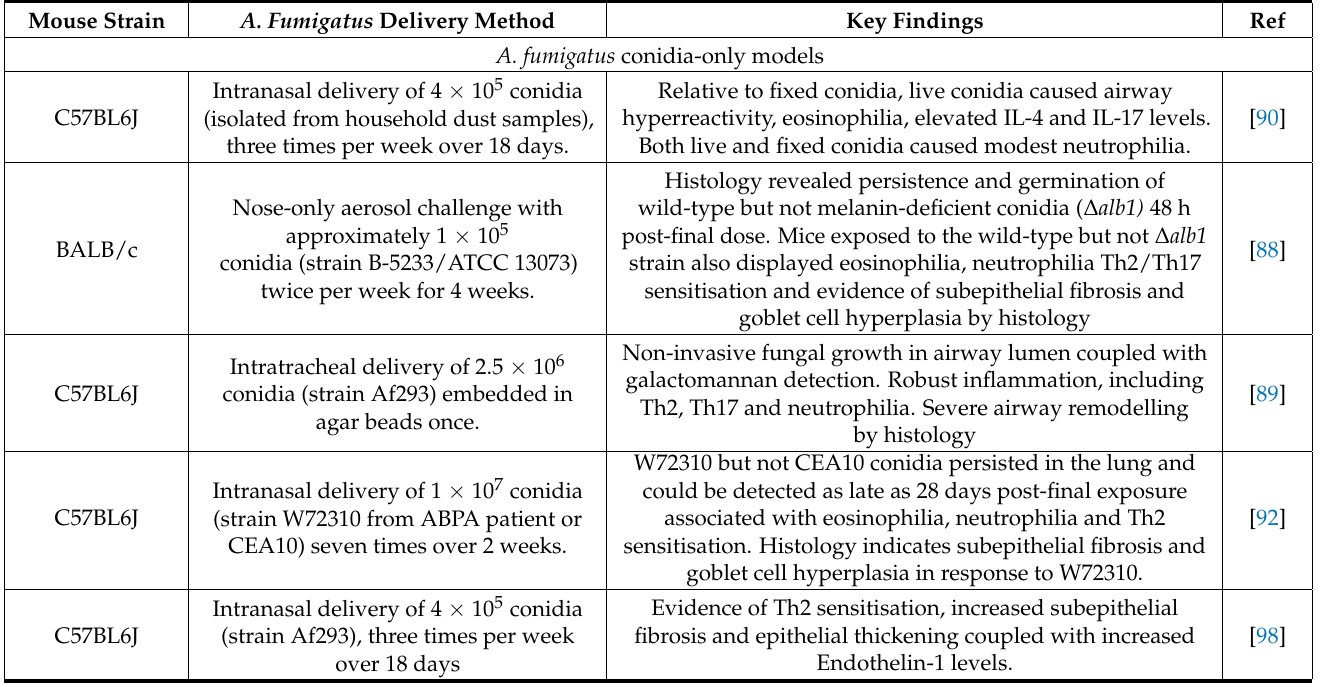
Table 1. Findings from selected mouse models of A. fumigatus airway